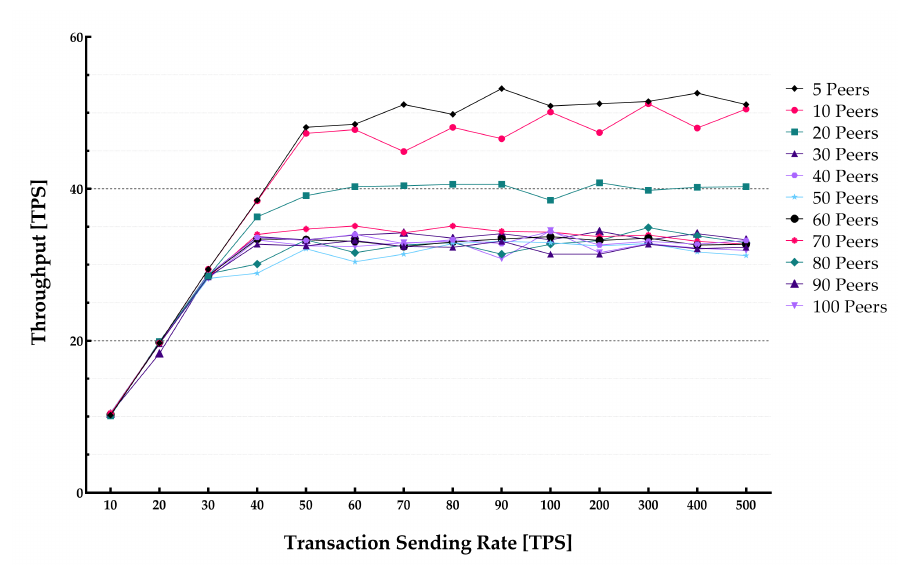
Figure 7. Transactions sending rate vs throughput for multiple host arrangement.